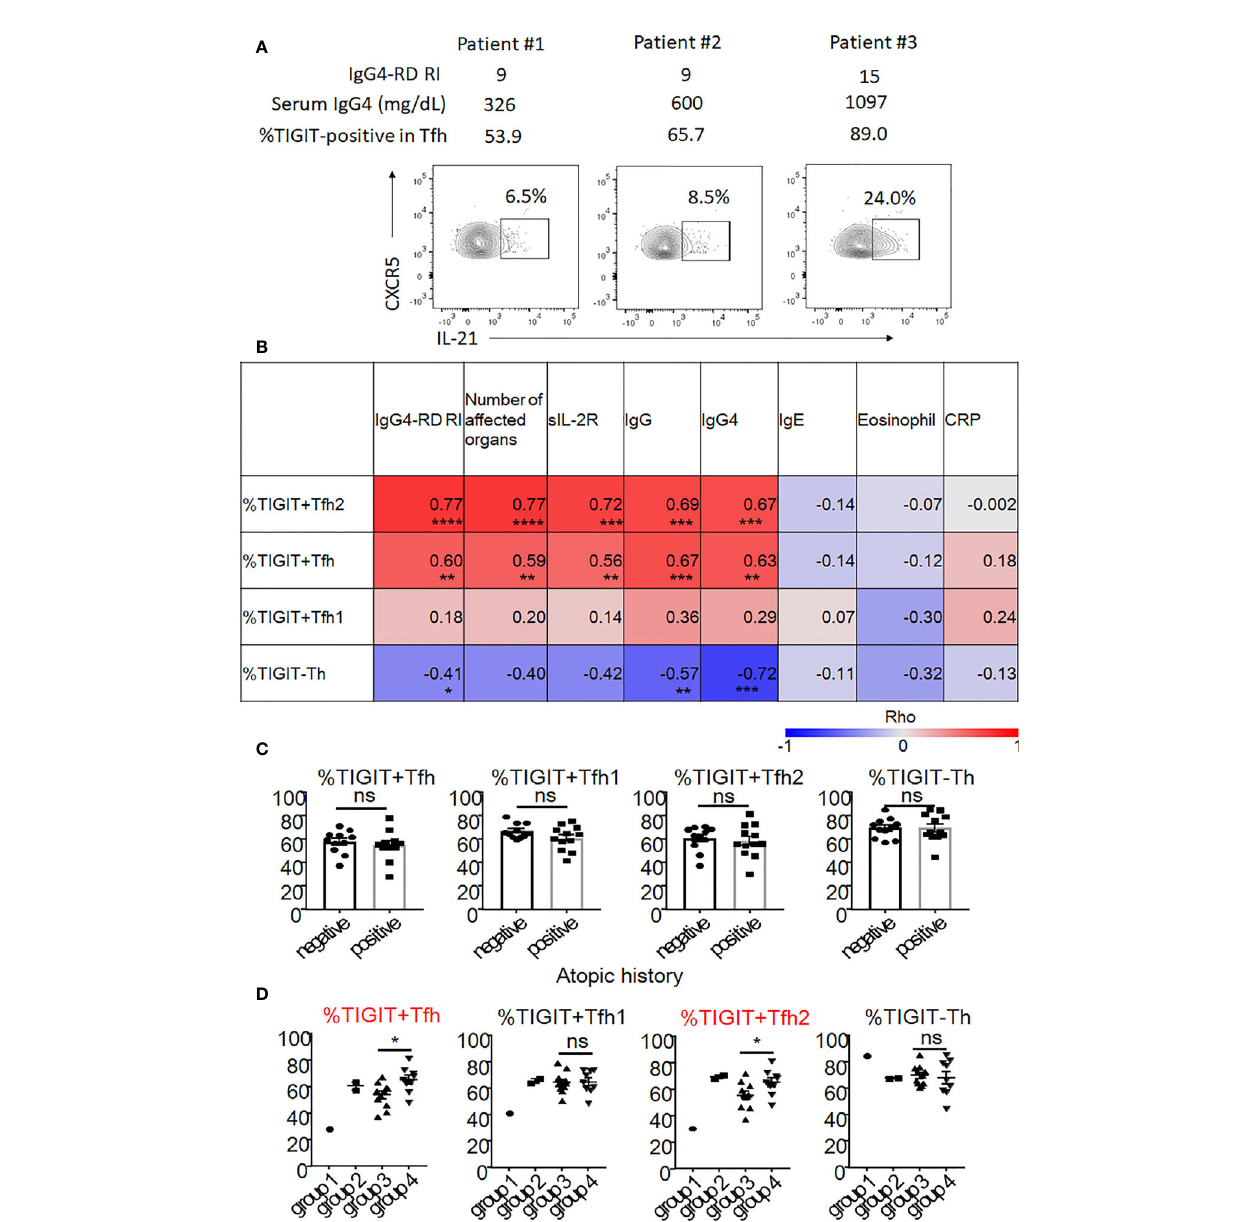
FIGURE 8 | The association of proportion of TIGIT + Tfh cells with disease activity and history of atopy of IgG4-RD. Correlation of IL-21 production in Tfh with disease activity was examined in 3 patients with untreated, active IgG4-RD (A) . Correlation of TIGIT + Tfh, TIGIT + Tfh1, TIGIT + Tfh2, and TIGIT - Th with clinical parameters in 23 patients with active, untreated IgG4-RD are shown as heat maps (B) . The proportion of TIGIT + Tfh, TIGIT + Tfh1, TIGIT + Tfh2, and TIGIT - Th was compared between patients with an atopic history and those without (C) . The proportion of TIGIT + Tfh, TIGIT + Tfh1, TIGIT + Tfh2, and TIGIT - Th are shown based on each clinical phenotype (groups 1-4). Statistical comparison was performed on groups 3 and 4 (D) . (B) Spearman ’ s correlation coef fi cient. (C, D) unpaired t test. ***p<0.0001, ***p<0.001, **p<0.01, *p<0.05, ns